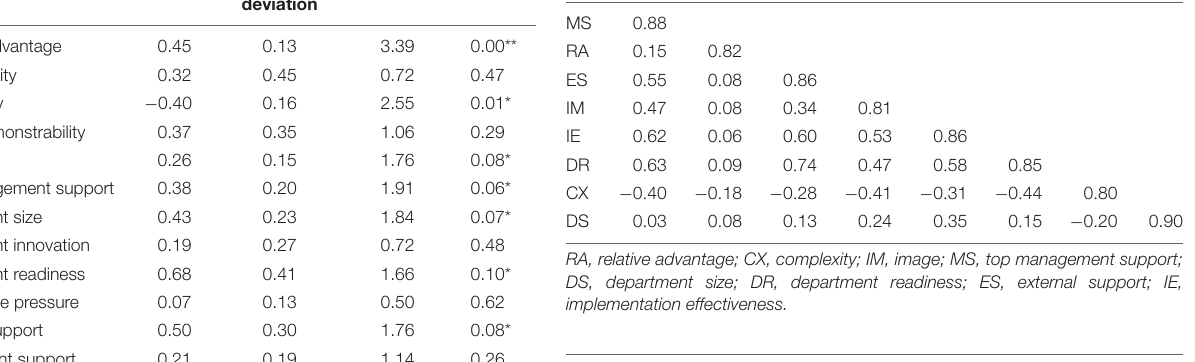
TABLE 10 | Testing results of the hypotheses affecting implementation